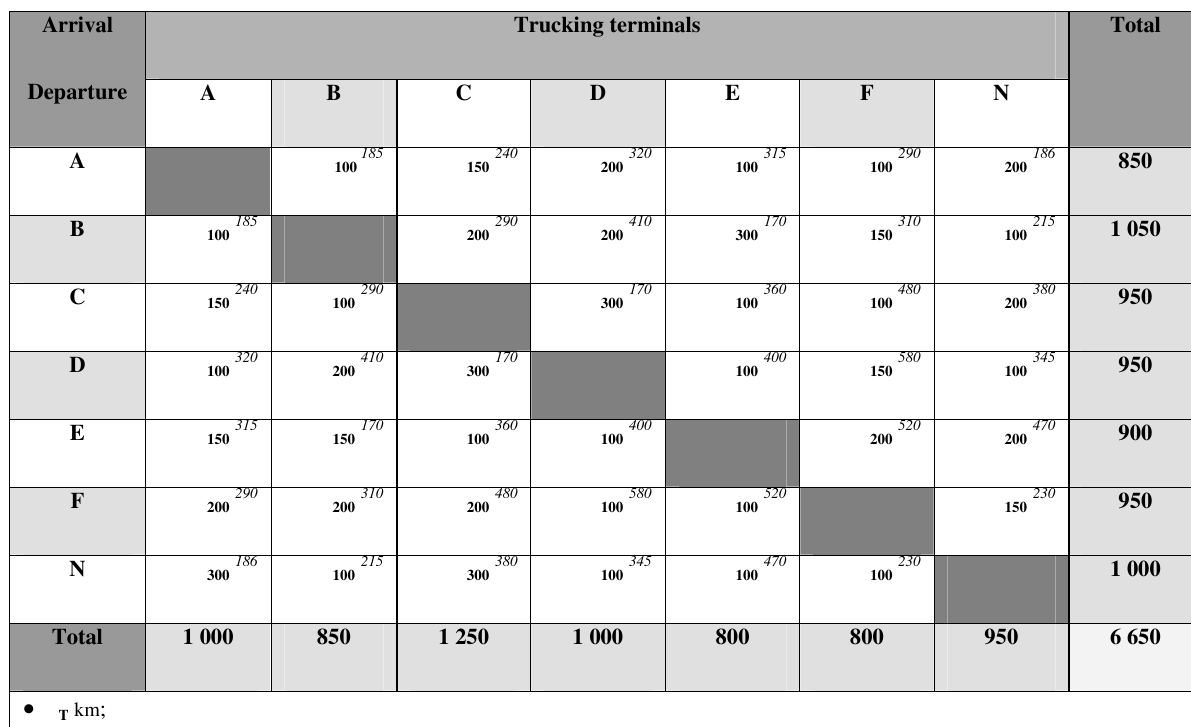
Table 1. Constant freight-exchange of trucking terminals (tons per day)